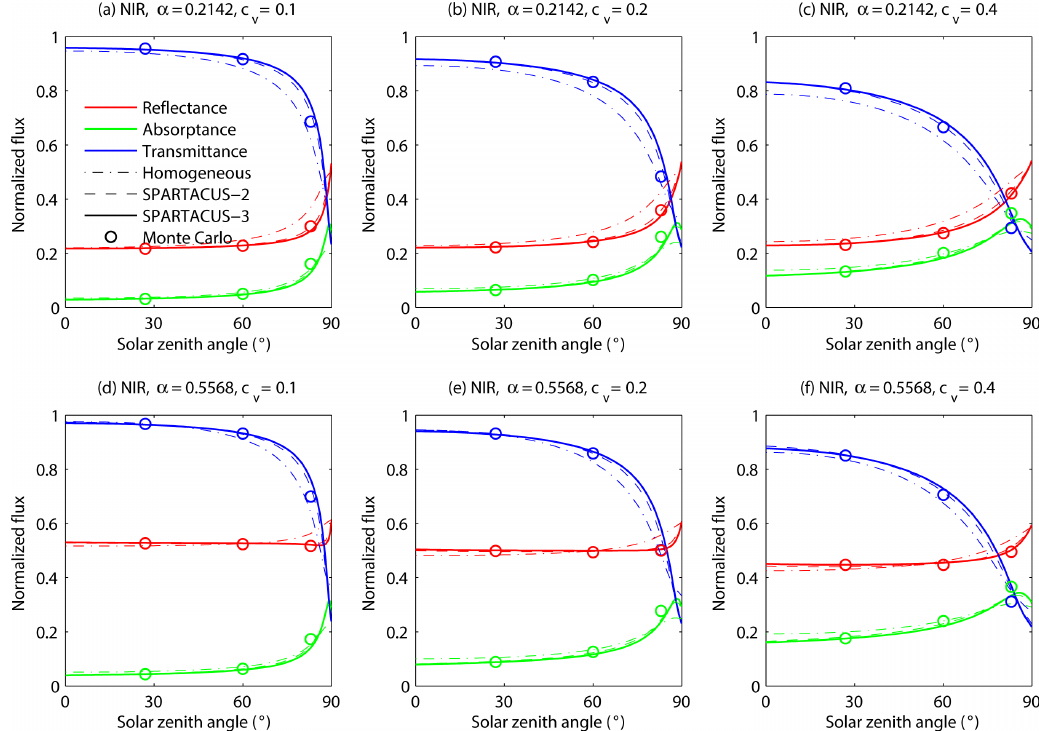
Figure 5. As Fig. 4 but with optical properties appropriate for near-infrared